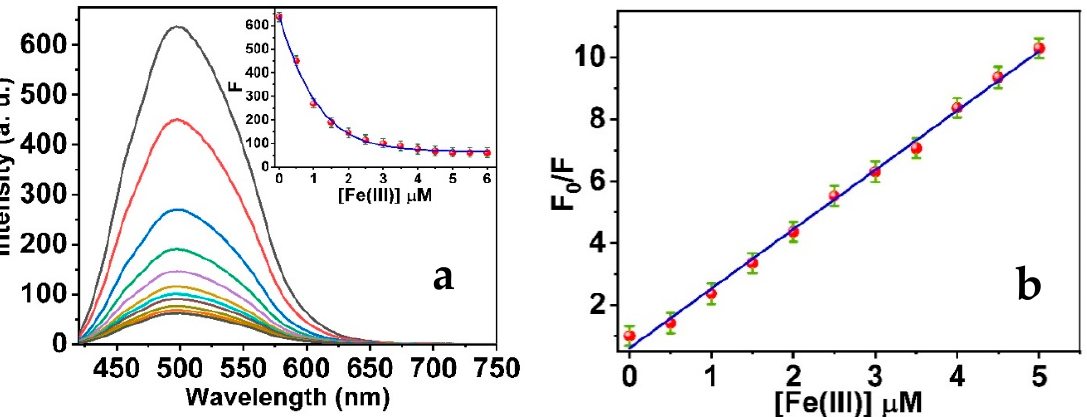
Figure 5. ( a ) Fluorescence emission of Tryp-AgNCs in the presence of a various concentration of Fe(III) ions from 0.1 to 6 mM; ( b ) Classical Stern–Volmer plot of fluorescence intensities ratio versus the quencher concentrations.